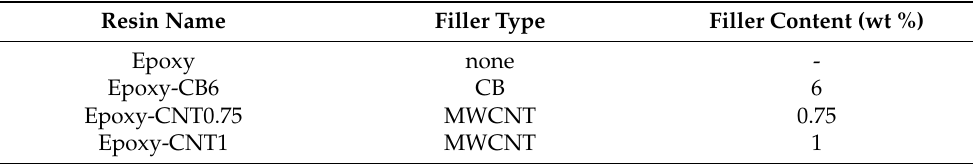
Table 1. Resin systems compositions.